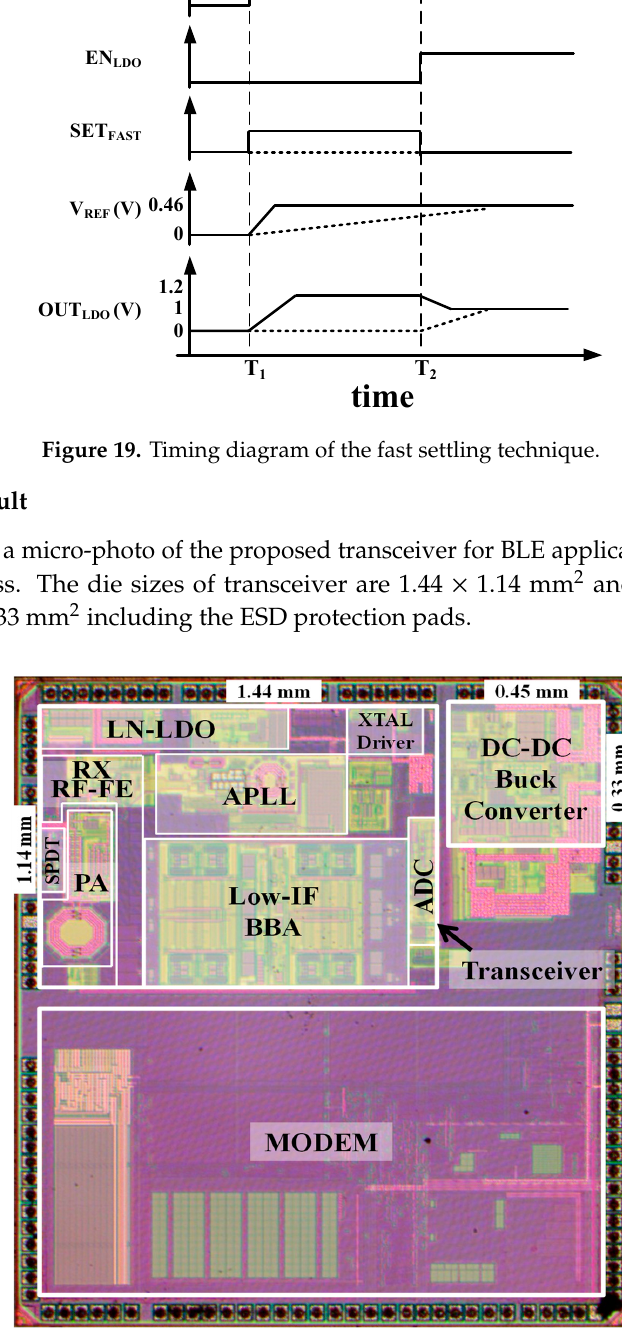
Figure 20. Chip micro-photo of the proposed BLE transceiver.